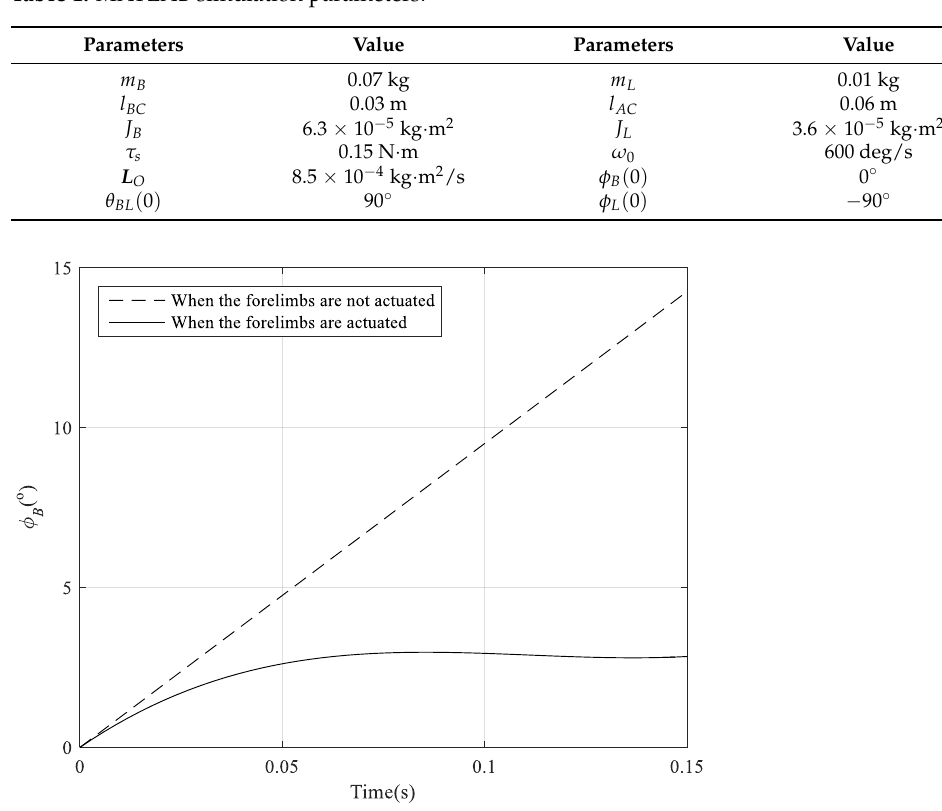
Figure 21. Simulation results for pitching adjustment under different angular speeds of forelimbs.